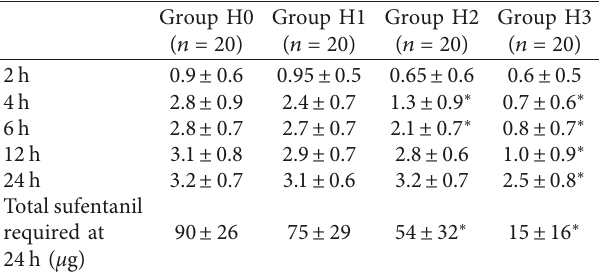
Table 2: Results for VAPSs at 2, 4, 6, 12, and 24h after injecting epidural hydromorphone and total analgesic requirement (PCIA with sufentanil) in the first 24 h.